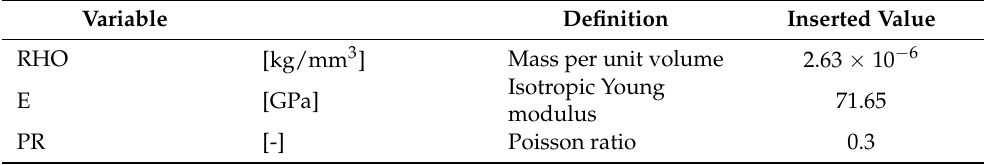
Table 5. MAT20 standard material parameters for rigid aluminum ASTM